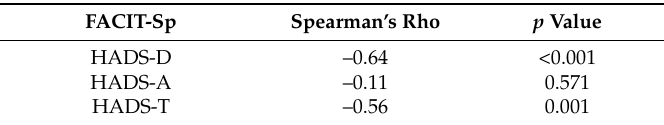
Table 5. Correlations between FACIT-Sp scores and HADS